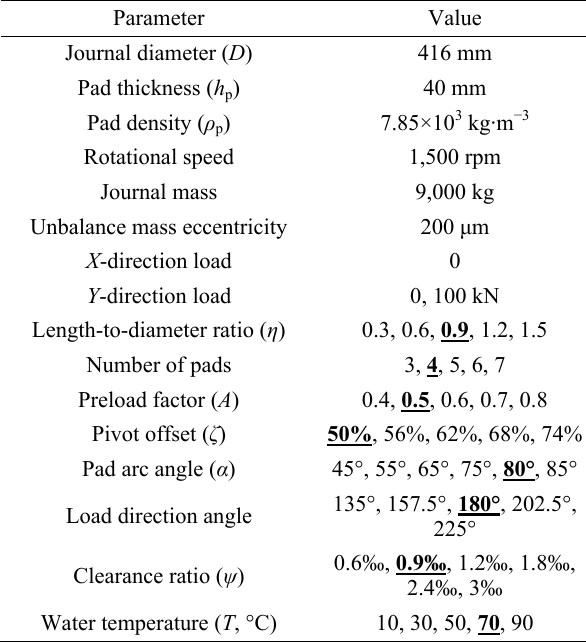
Table 1 Structural and operational parameters of a water- lubricated TPJB.